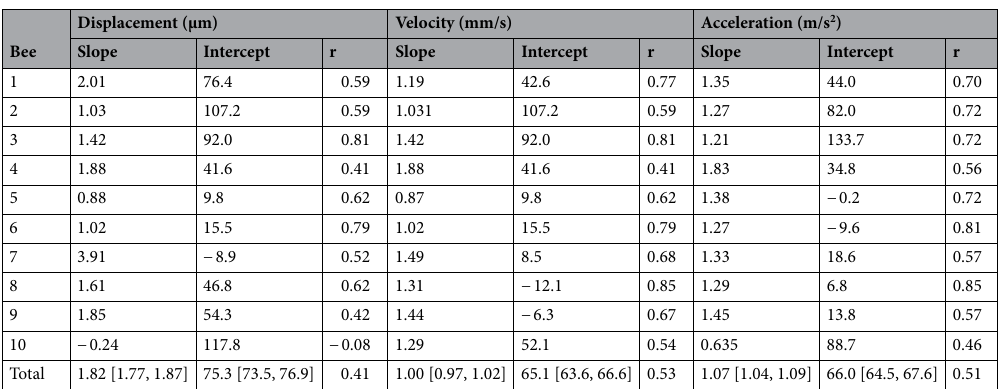
Table 2. Linear models relating peak thorax displacement/velocity/acceleration to peak force in the x-direction. ‘Total’ indicates linear model for all measurement intervals for all carpenter bee individuals. Square brackets in the ‘total’ row indicate the 95% confidence intervals of the linear